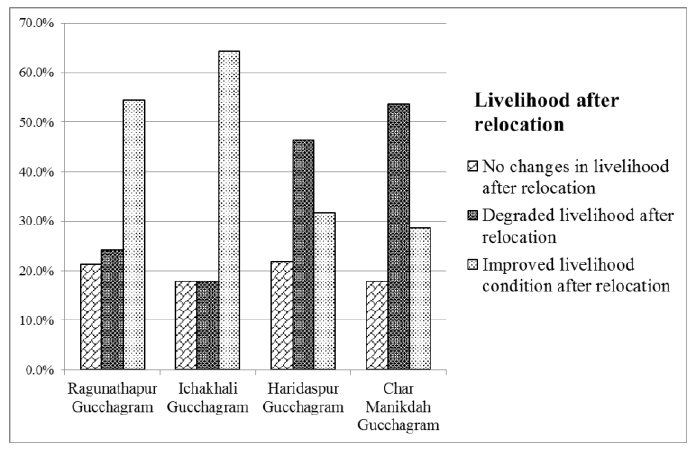
Figure 4. The livelihood situation after relocation across the GGs; source: field survey 2014.